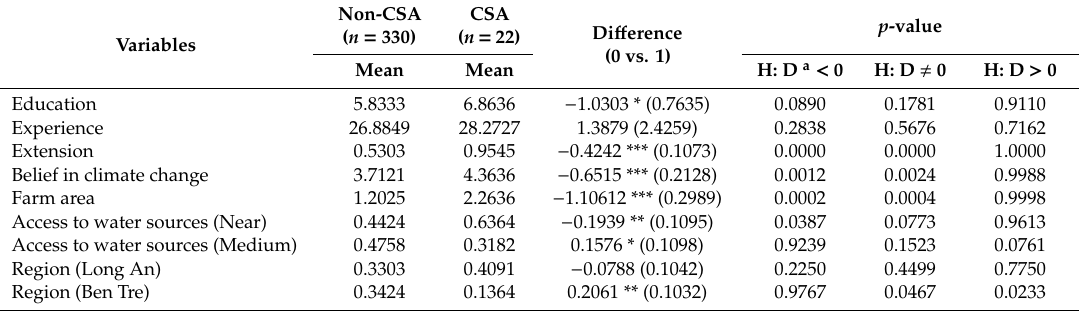
Table 3. Di ff erence between control and treatment group regarding CSA